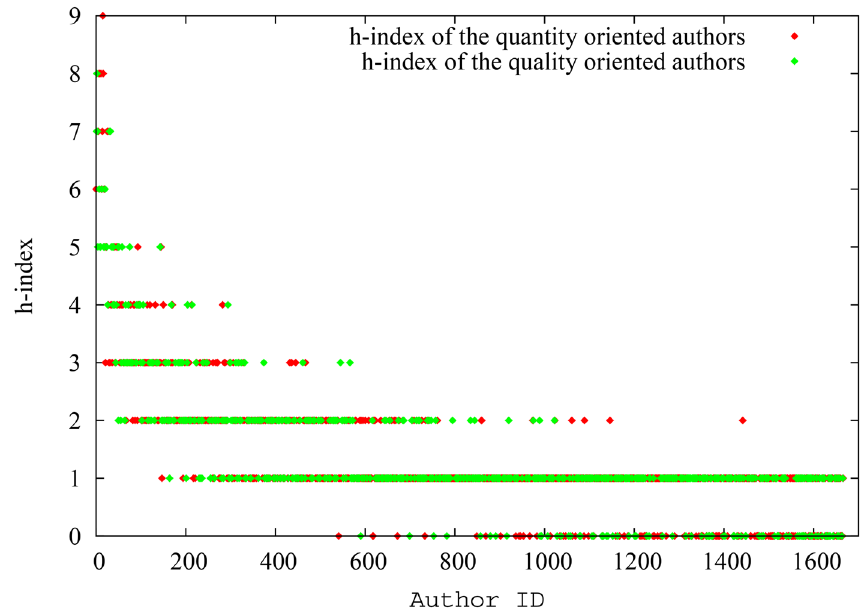
Fig 11. The spread of h-index for quantity oriented authors and quality oriented authors (as absolute values) in scenario 3. Considering authors with the same level of seniority (as indicated by the IDs), the ‘ quantity-oriented ’ authors have a clear advantage over ‘ quality-oriented ’